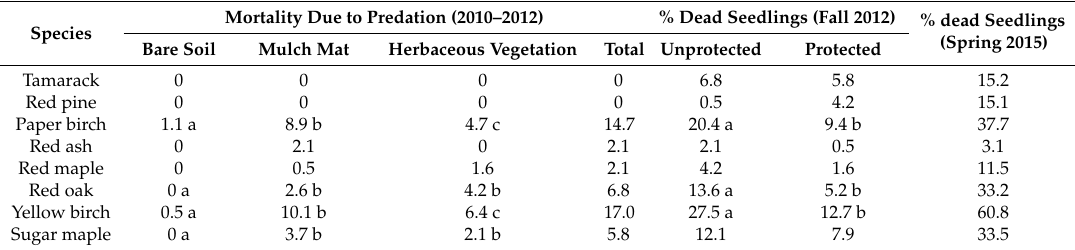
Table 3. Tree mortality (%) due to predation compared between vegetation treatments (evaluated using signs of lethal small mammal damage on unprotected and protected seedlings, data compiled from Spring 2010 to Autumn 2012), tree mortality in Autumn 2012 compared between protection treatments, and tree mortality in Spring 2015